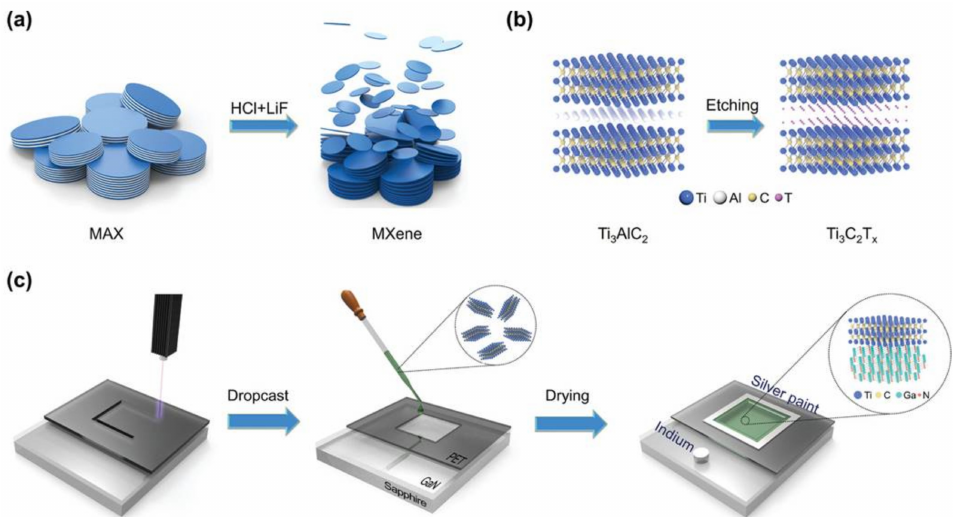
Figure 2. The synthesis process of Ti 3 C 2 T x MXene and Ti 3 C 2 T x -GaN heterostructure. ( a ) Schematic of synthesis of MXene from MAX phase. ( b ) Schematic of the preparation of 2D Ti 3 C 2 T X nanosheets. ( c ) Schematic of the fabrication of Ti 3 C 2 T x /GaN van der Waals heterostructure device. Reprinted with permission from Ref. [59]. 2021, John Wiley and Sons.